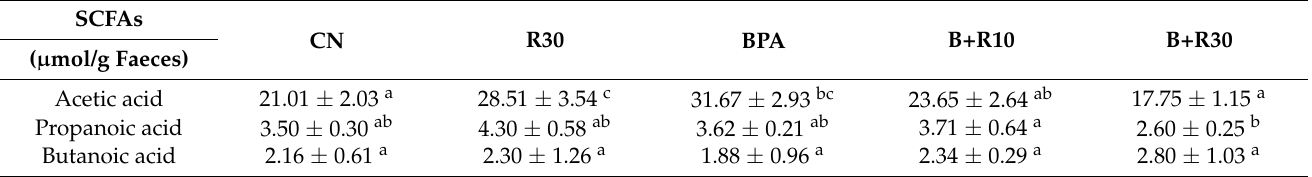
Table 2. SCFA concentrations in the faeces of female offspring